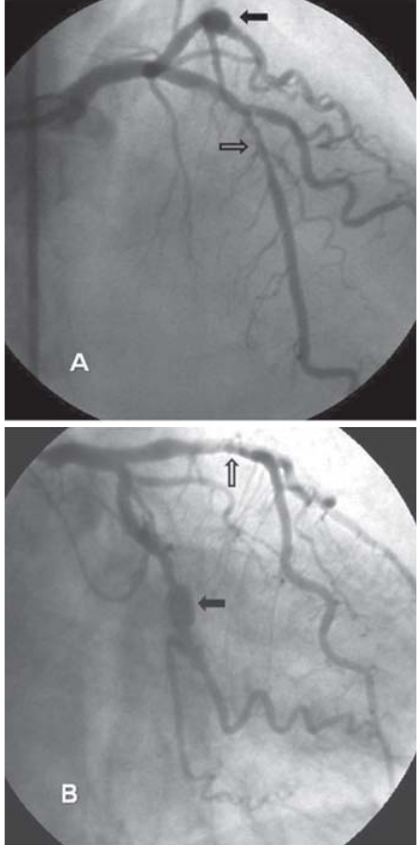
Fig. 1 - Cinecoronariografia em duas projeções, A e B, mostrando aneurisma pós-implante de stent farmacológico em artéria circunflexa (seta negra) e lesão segmentar em artéria descendente anterior (seta